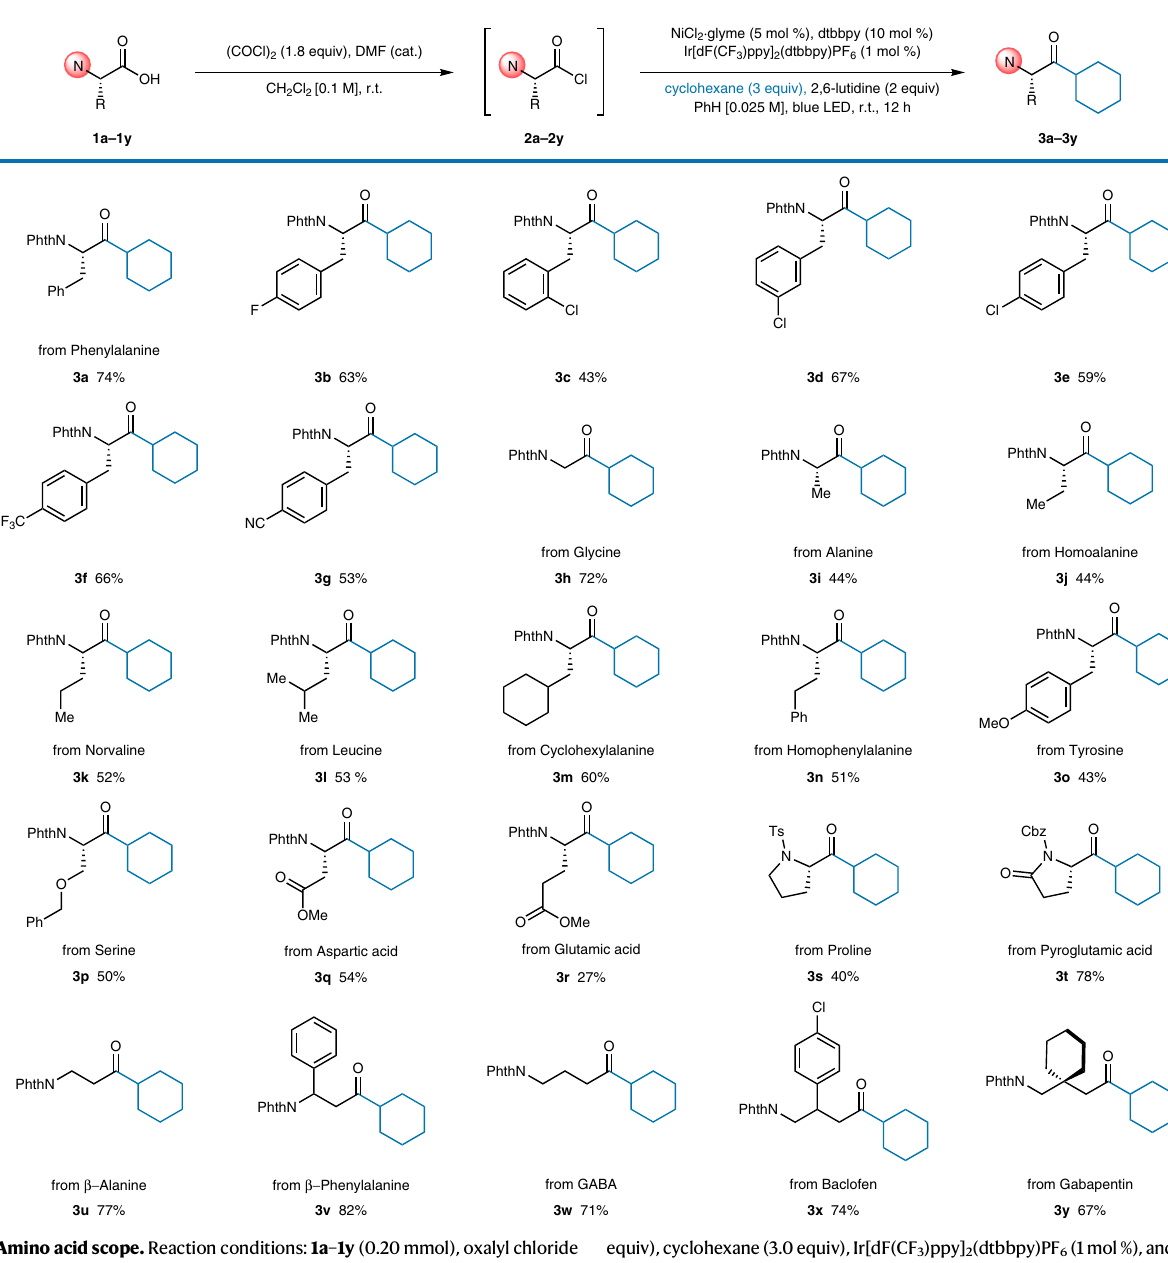
equiv),cyclohexane(3.0equiv),Ir[dF(CF 3 )ppy] 2 (dtbbpy)PF 6 (1mol%),andbenzene (8.0mL) were added, and the solution was irradiated for 12h with a Penn PhD M2 photoreactor. All yields are isolated